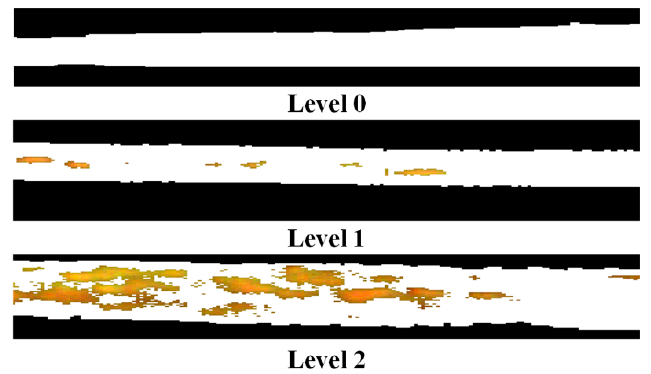
Figure 4. The segmentation results of disease spots for the three levels.